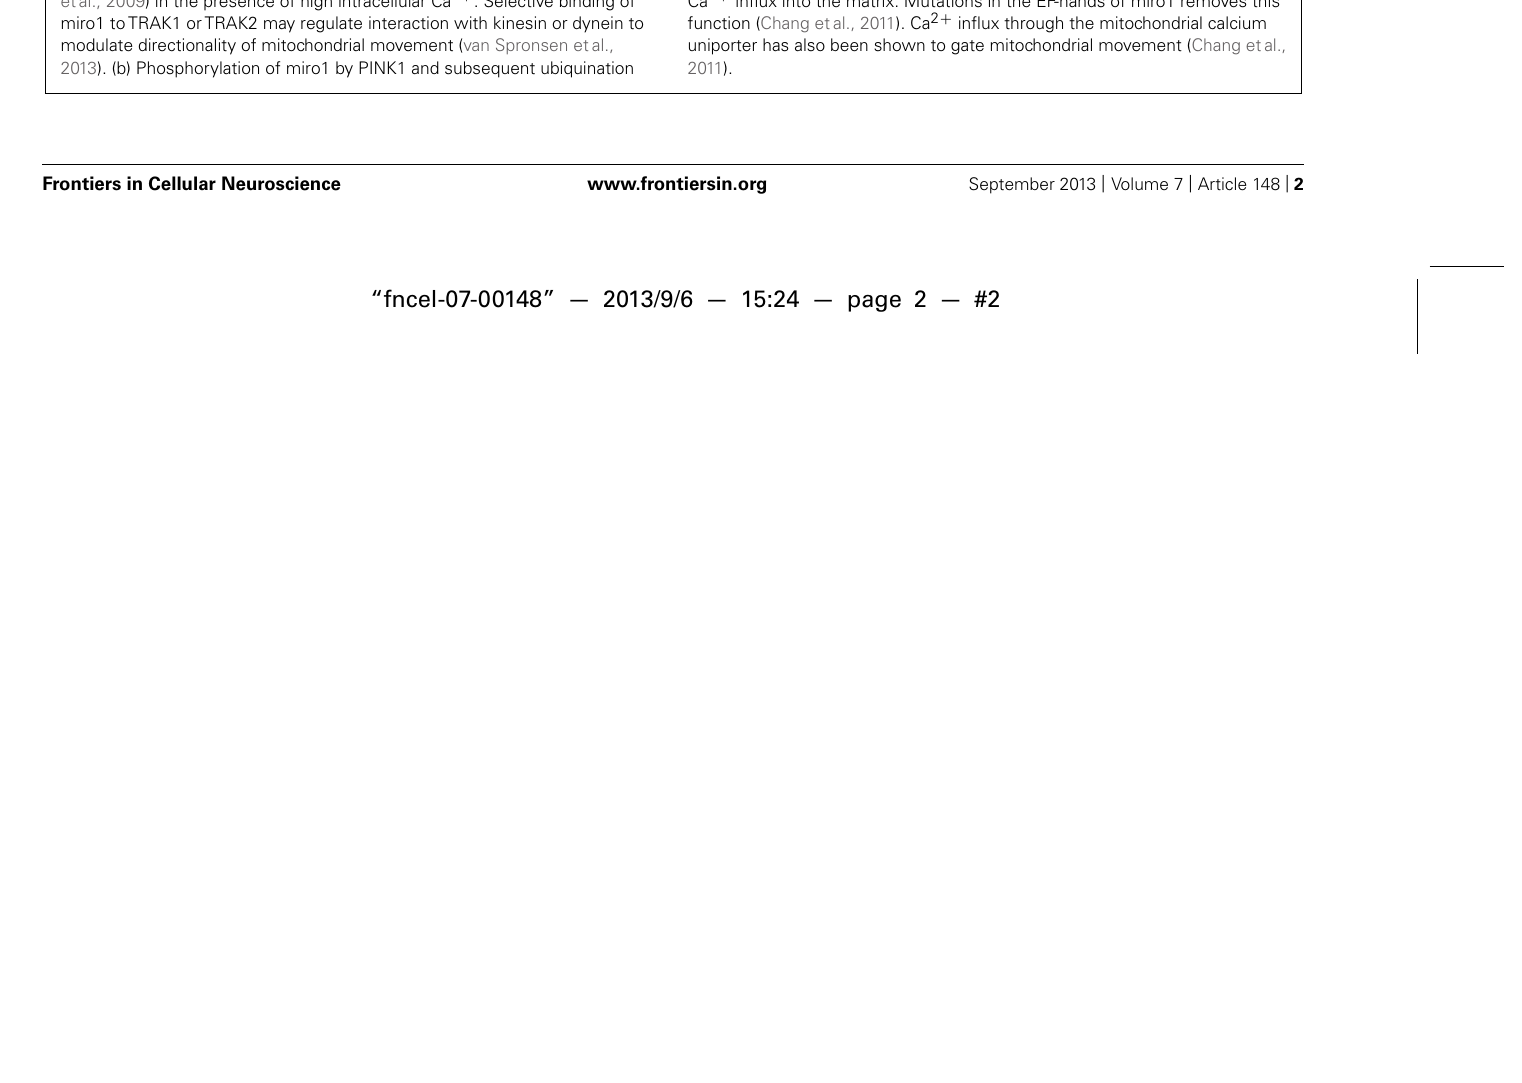
FIGURE 1 | Miro is the nexus of mitochondrial function and transport. (a) Miro1 has been proposed to differentially regulate motor–microtubule interaction (Wang and Schwarz, 2009) orTRAK–motor interaction (Macaskill etal., 2009) in the presence of high intracellular Ca 2 + . Selective binding of miro1 toTRAK1 orTRAK2 may regulate interaction with kinesin or dynein to modulate directionality of mitochondrial movement (van Spronsen etal., 2013). (b) Phosphorylation of miro1 by PINK1 and subsequent ubiquination